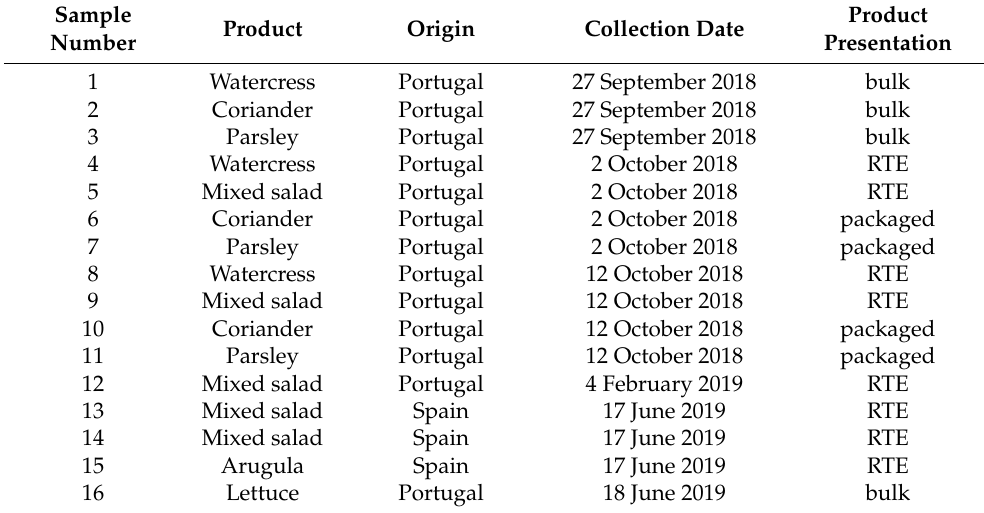
Table 1. Origin, collection date, and product presentation of the vegetable